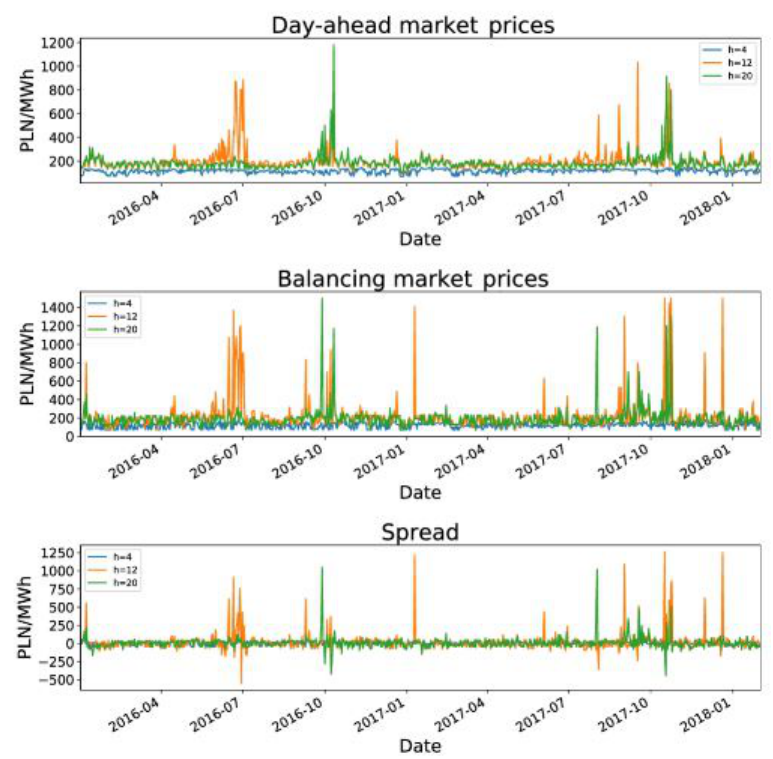
Figure 1. Day-ahead prices, balancing prices, and spread for sample hours, h ∈ { 4,12,20 } , quoted on each day from the period from 1 January 2016 until 1 January 2018. Table 2. Comparison of the mean and the standard deviation (SD) of the electricity prices. Day-Ahead